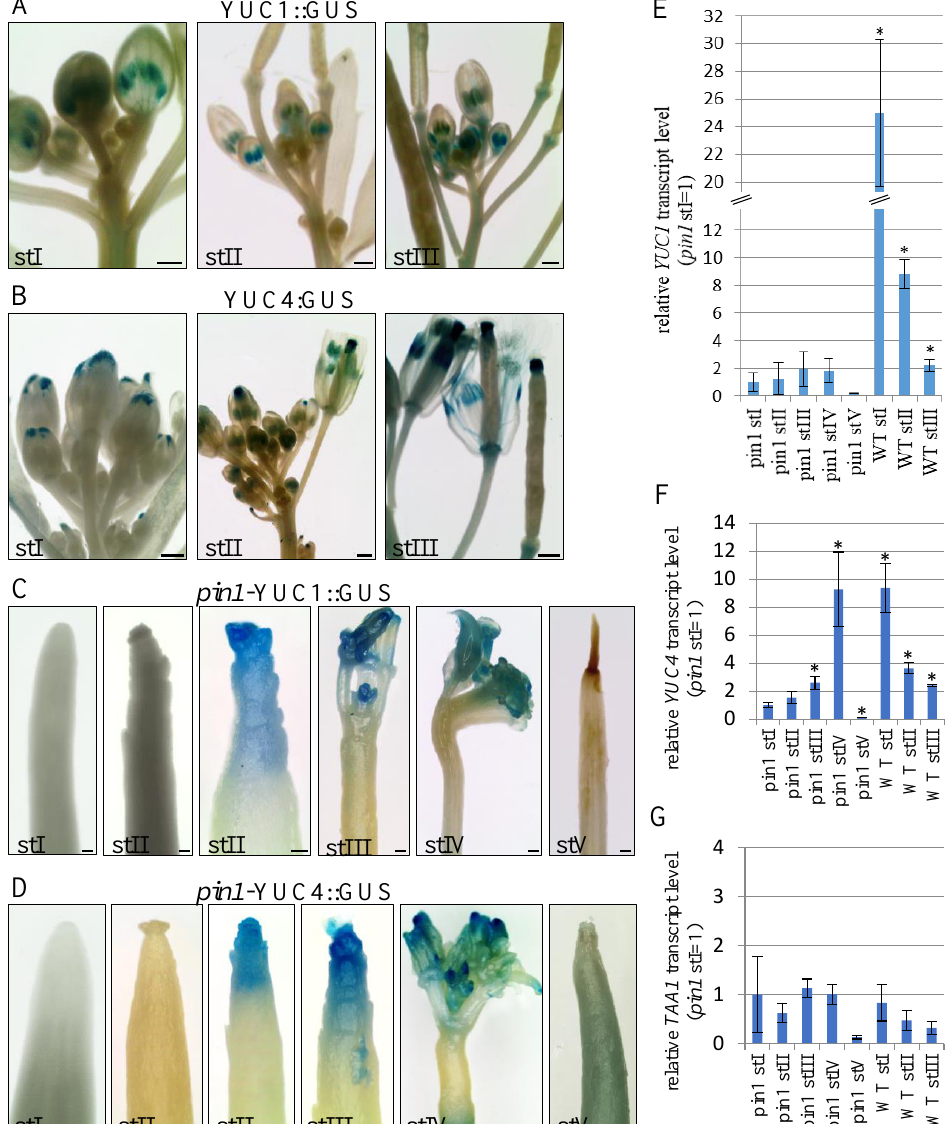
Figure 6. Expression analyses of auxin biosynthesis genes YUC1 and YUC4 . ( A – D ) Activity of the YUC1 ( A , C ) and YUC4 ( B , D ) promoters visualized by the activity of the GUS reporter protein (blue). In WT plants, in stages I-III, activity of the p YUC1:GUS ( A ) and p YUC4:GUS ( B ) reporters is visible in developing organs. In pin1 mutants the expression of p YUC1:GUS ( C ) and p YUC4:GUS ( D ) is not detected in stage I plants; is visible in some shoots with organ primordia in stage II plants; is present in most plants from stages III and IV; and is not detected in stage V plants. ( E – G ) The comparison of YUC1 ( E ), YUC4 ( F ) and TAA1 ( G ) transcript levels during different ontogenetic stages of inflorescence shoots development of WT and pin1 mutant plants. Abundance of the transcripts, in each case, is relative to the pin1 stage I sample. The level of YUC1 and YUC4 genes expression in pin1 mutants increases during ontogenesis, but yet is generally weaker in comparison to WT plants. The level of TAA1 gene expression in WT plants and pin1 mutants does not generally significantly differ. Statistically significant differences to the pin1 stage I sample are denoted with asterisk ( t -test, significance at p = 0.05). St. I–V ( pin 1 ) and St. I–III (WT)—successive developmental stages. Scale bar 500 µ